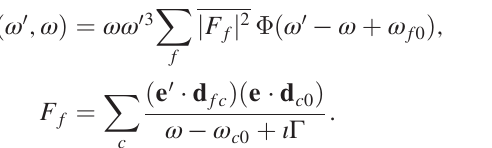
3 π 1 contributing g u i